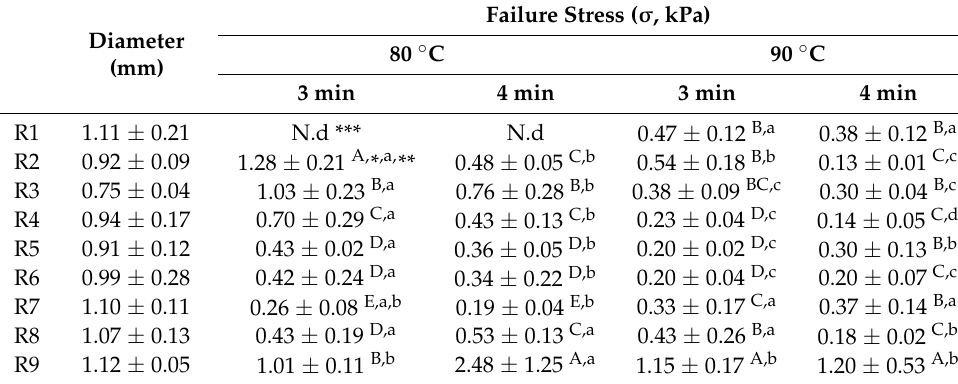
Table 2. Diameter of rice noodles before cooking and the failure stress ( σ ) of cooked rice noo- dle